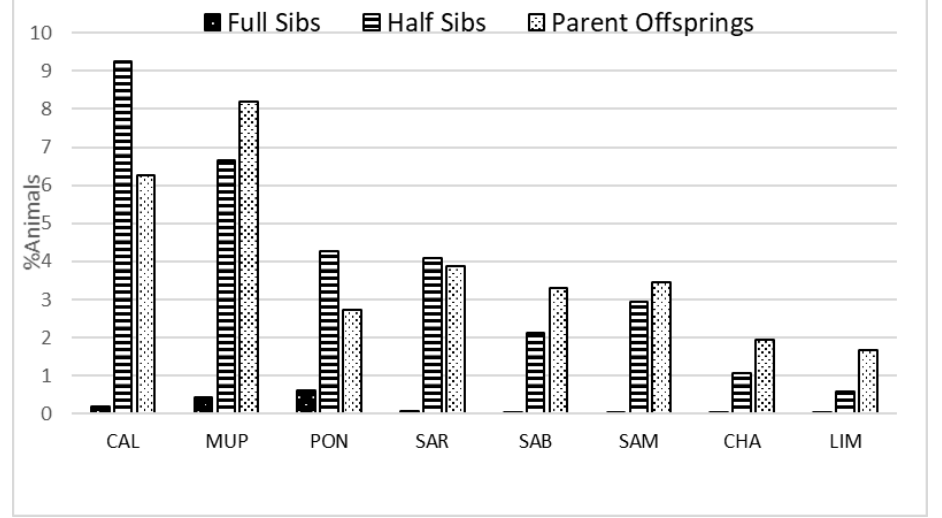
Figure 2. Percentage of animals involved in matings between close relatives (between full-siblings (sibs), half-sibs, and parent – offspring) in each breed, where CAL = Calvana; MUP = Mucca Pisana; PON = Pontremolese; SAR = Sarda; SAB = Sardo Bruna; SAM = Sardo Modicana; CHA = Charolais; LIM = Limousine.